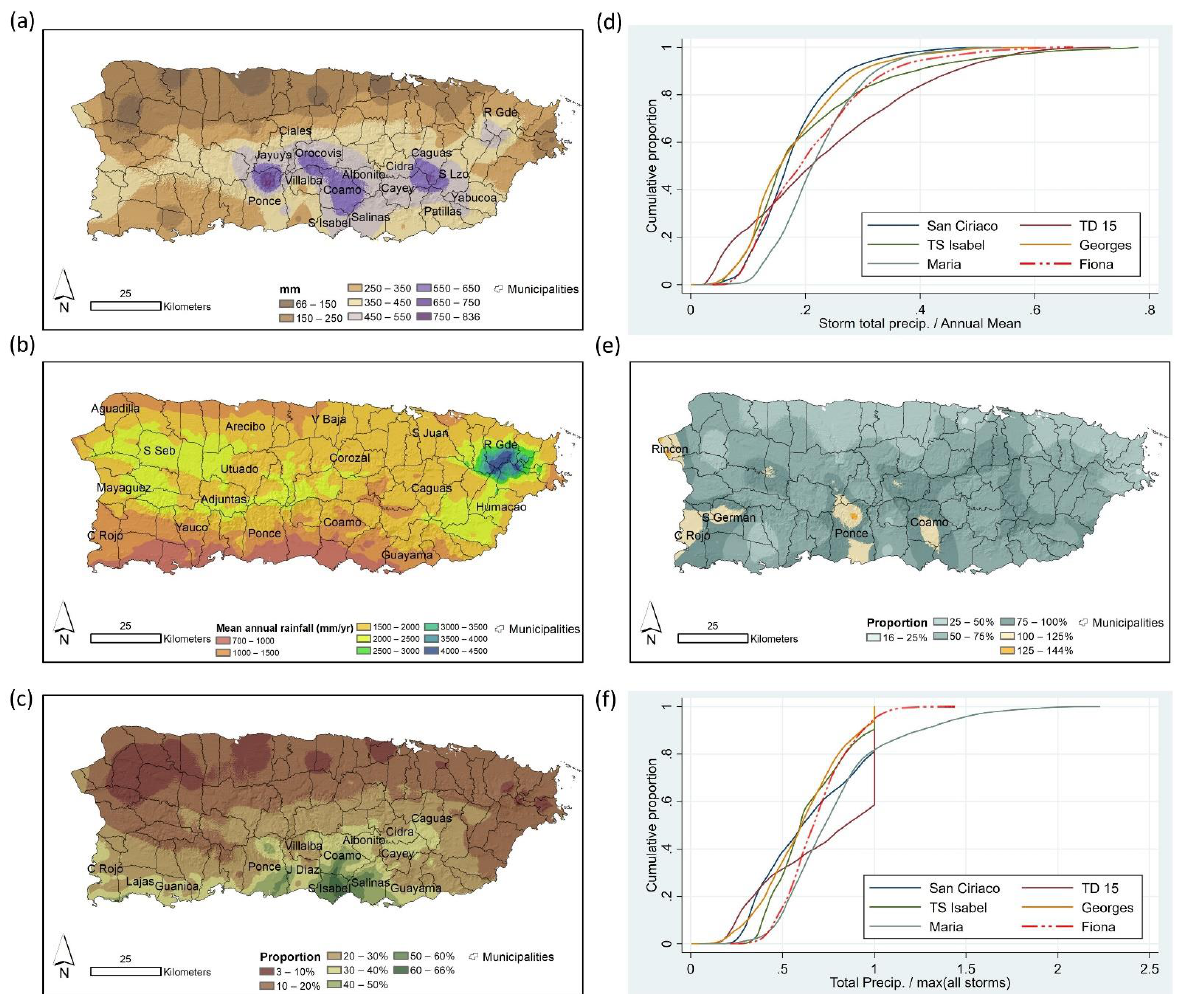
Figure 5. Hurricane Fiona’s total rainfall (TR) versus annual normal rainfall. ( a ) Spatial distribution of TR in mm during Hurricane Fiona based on co-kriging analysis of rainfall recorded between the 17th and the 19th of September 2022 at 113 weather stations; ( b ) Mean annual rainfall for Puerto Rico in mm (modified from [43]); ( c ) Ratio of Hurricane Fiona’s TR to mean annual rainfall; ( d ) Cumulative distribution curves for the proportion of annual rainfall caused by Huracán San Ciriaco (1899), Tropical Depression 15 (1970), Tropical Storm Isabel (1985), Hurricane Georges (1998), Hurricane María (2017), and Hurricane Fiona; ( e ) Proportion of Hurricane Fiona’s TR relative to the maximum total rainfall recorded for 60 tropical cyclones that have affected PR since 1899 with the exception of Hurricane María; ( f ) Cumulative distribution curves of the proportion of maximum tropical cyclone rainfall recorded in PR from 1899 to 2022 (not including Hurricanes María and Fiona) (data for storms previous to Hurricane Fiona taken from Ramos-Scharron and Arima [28]).